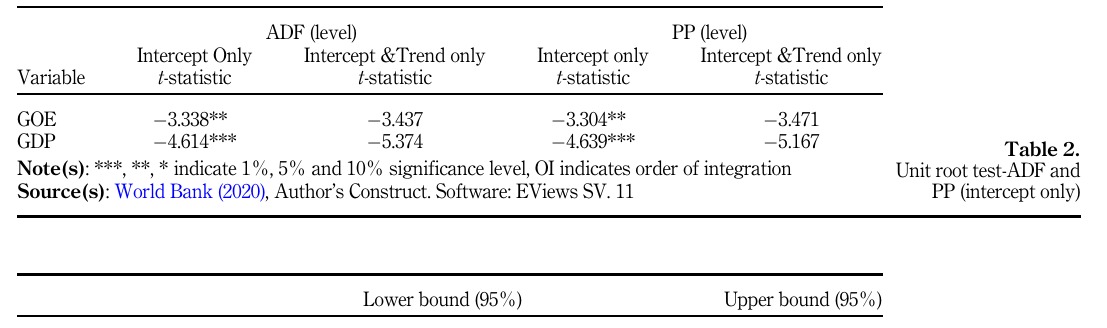
Table 3. Test of